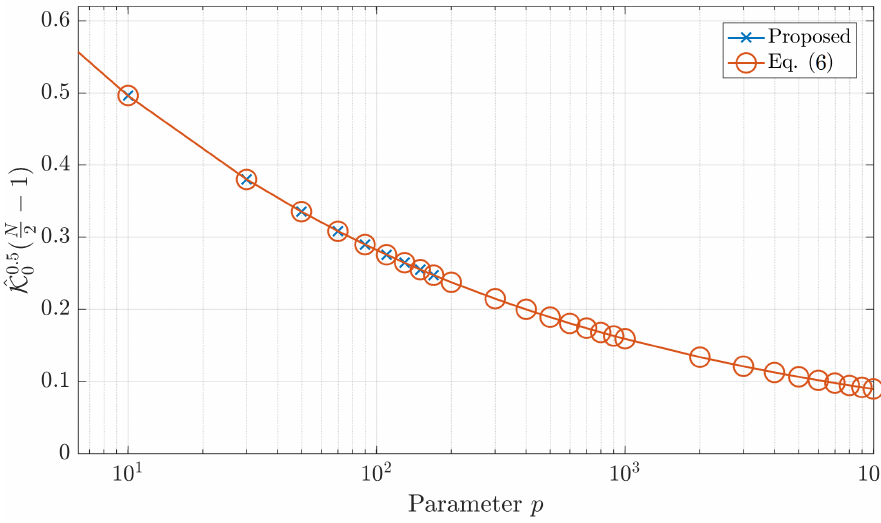
(cid:16) (cid:17) N − 1 using the proposed formula (Equations (9)) and 0 2